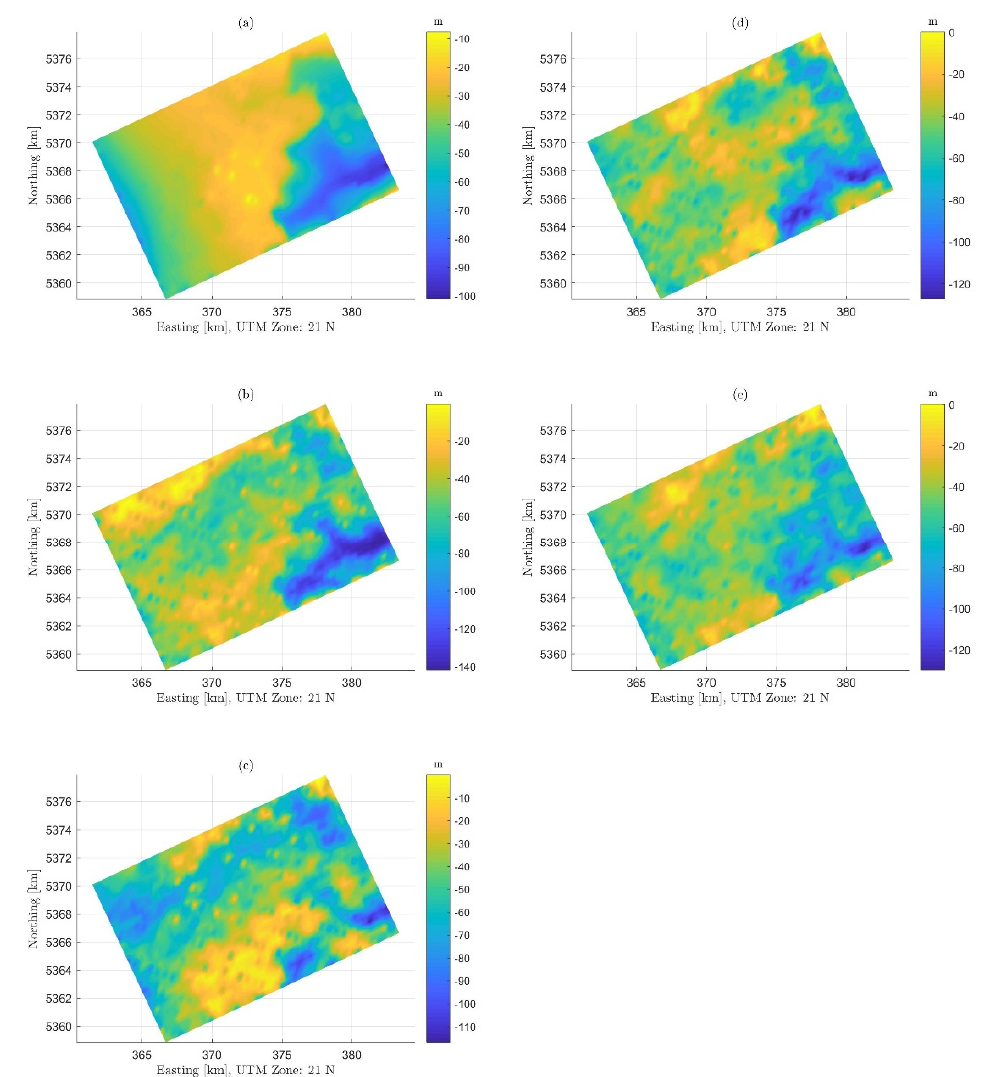
Figure 6. ( a – e ) The seafloor topography estimated from gravity gradients using simulated annealing in experiment No. 0 to No. 4,